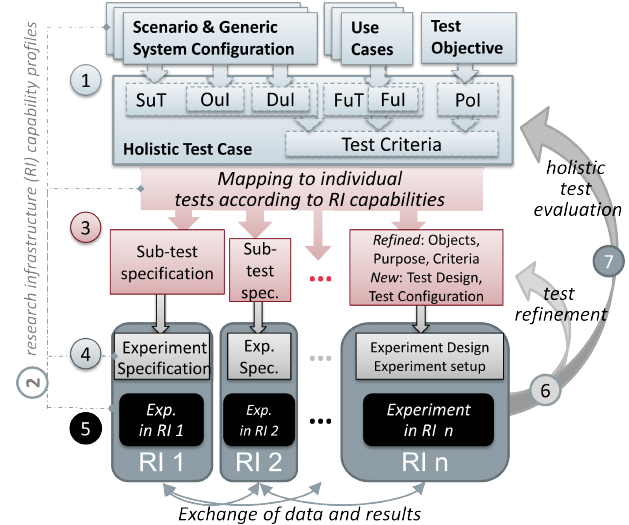
Figure 12. Overview of the ERIGrid holistic testing approach